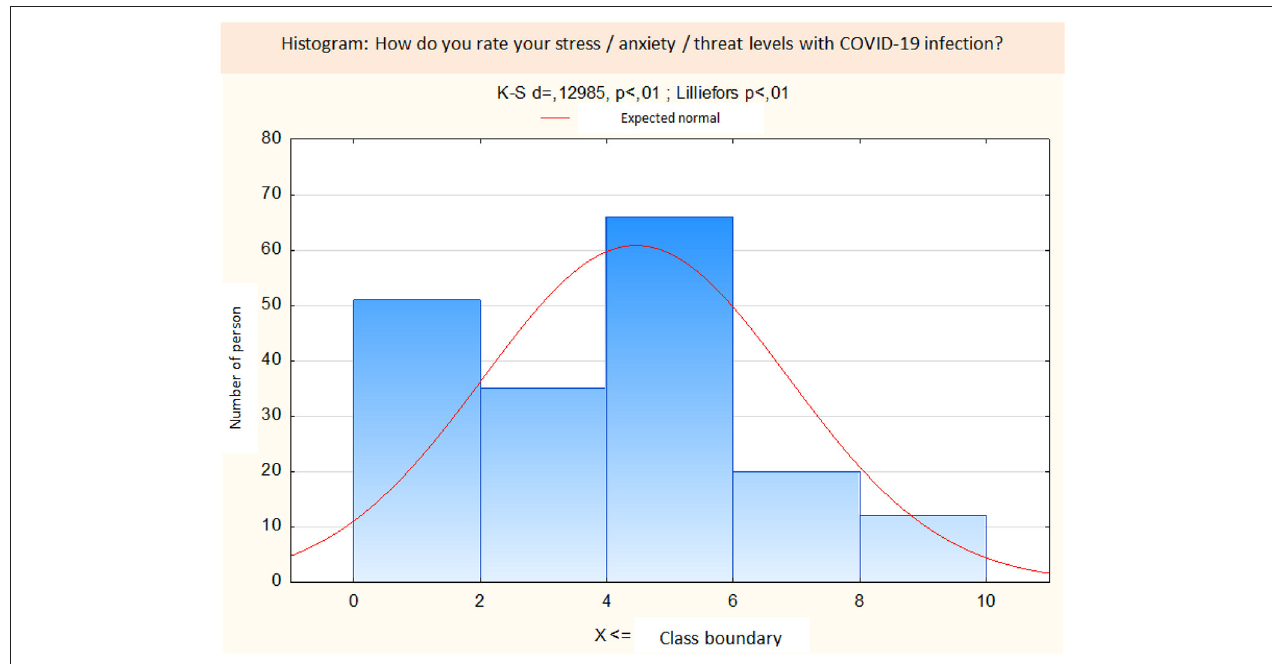
FIGURE 1 | Distribution histogram of self-assessment of the level of stress/anxiety/risk related to the possibility of COVID-19 infection.